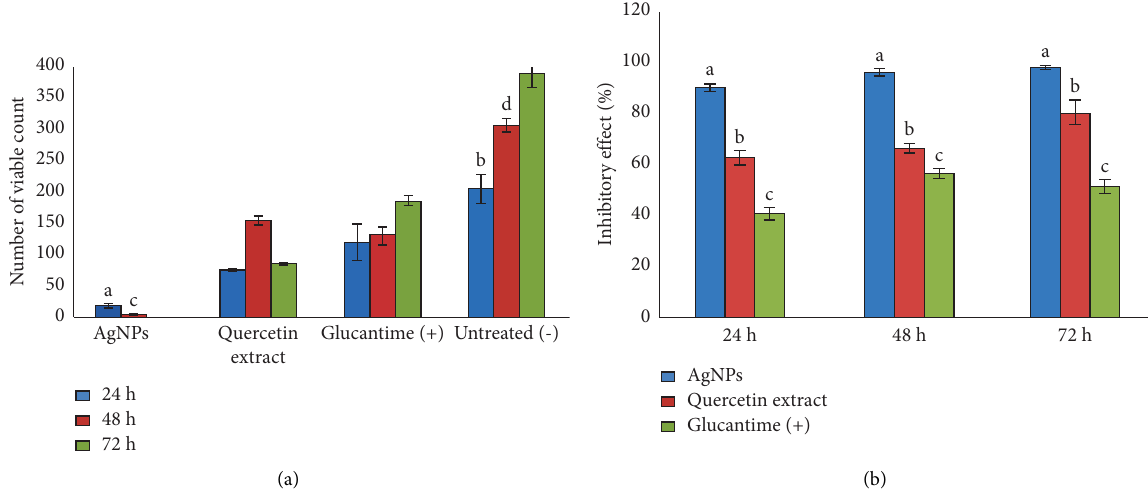
Figure 2: Time-dependent cytotoxicity of synthesized AgNPs and quercetin against L. major promastigotes. Te number of viable cells in controls and treated samples at diferent time intervals (24, 48, and 72hr) (a). Te percent of growth inhibition after exposure to silver nanoparticles, quercetin, and glucantime at various time intervals (24, 48, and 72 hr) (b).